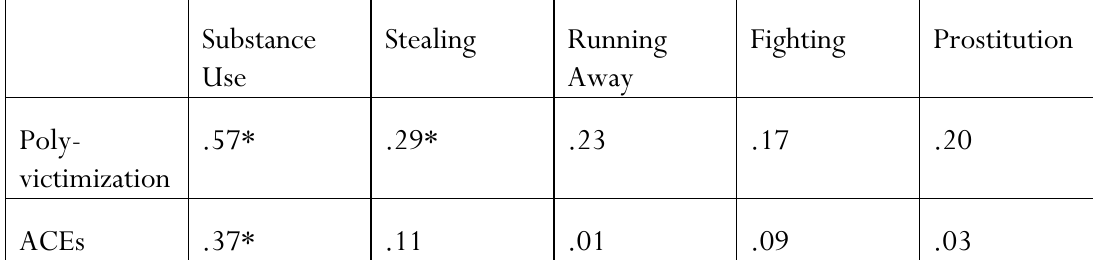
Table 21: Pearson Correlations of Duration of Crime with Poly-victimization &